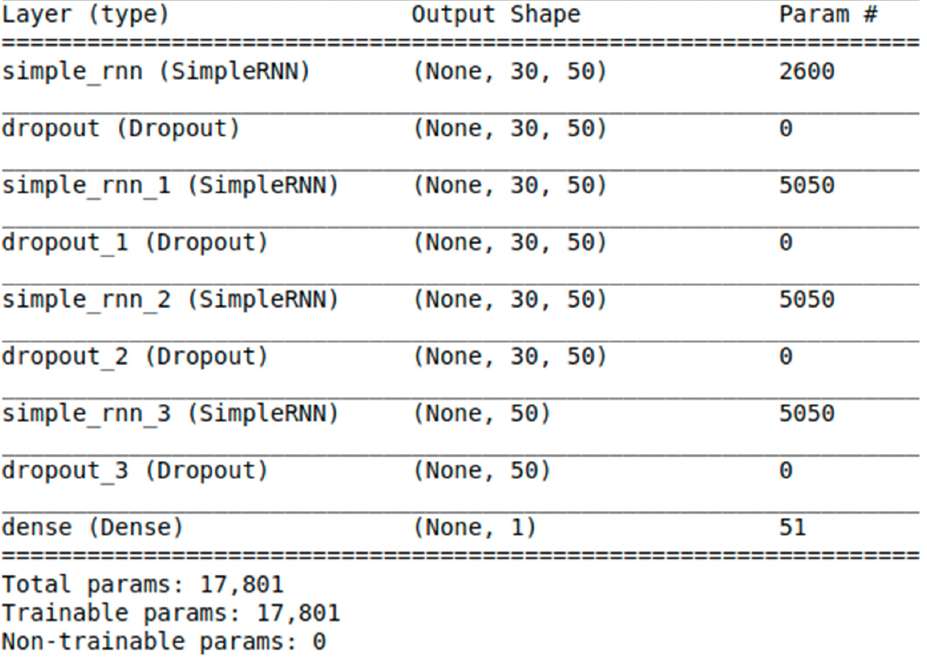
Figure 3. Model architecture and configuration parameters.